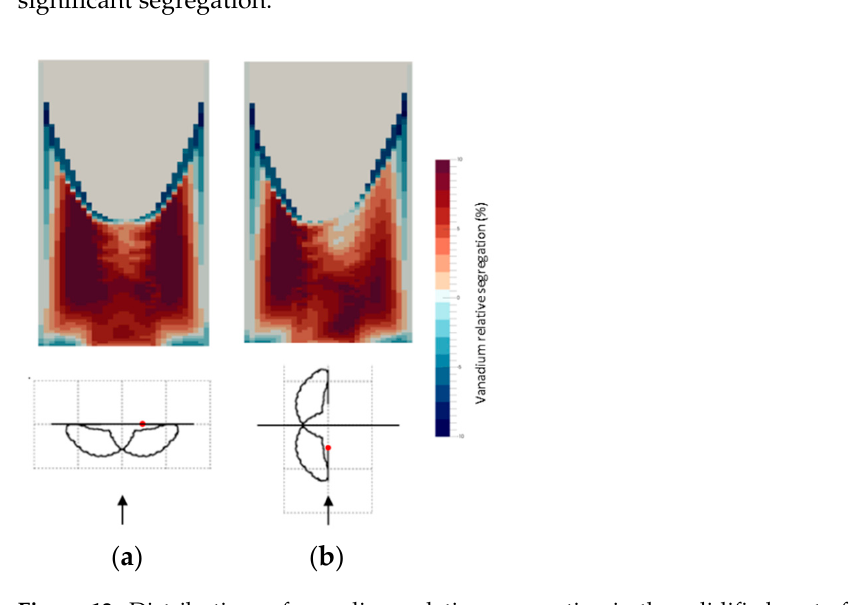
Figure 13. Distributions of vanadium relative segregation in the solidified part of the ingot. The results are shown in two perpendicular transverse sections ( a ) 𝑦 = 0 and ( b ) 𝑥 = 0 of the ingot at the same time instant considered in Figure 10.